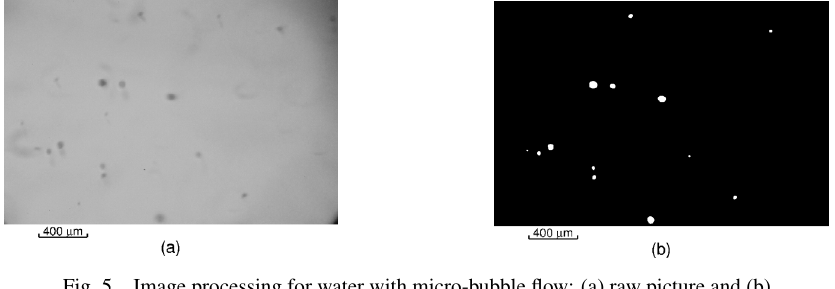
Fig. 5 Image processing for water with micro-bubble flow: (a) raw picture and (b) binary